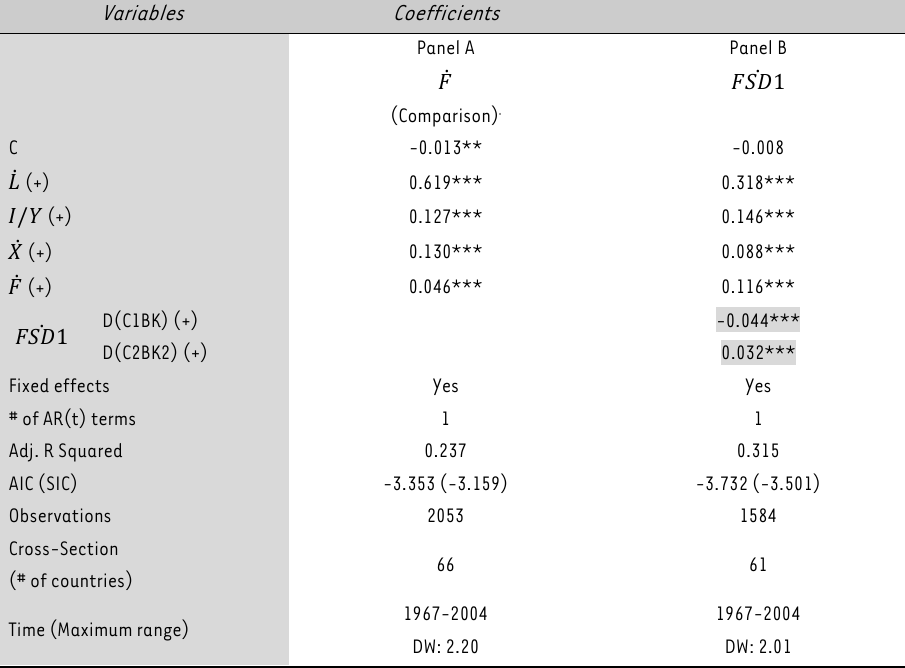
Basic panel regression results: alternative measures of financial sector